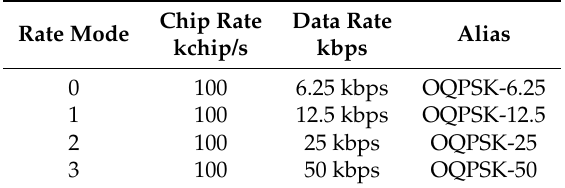
Table 3. Radio settings using O-QPSK modulation. The values of these parameters are defined in the standard [22]. The rate mode defines the resulting data rate. The radio signal is composed by chips; in the 868 MHz frequency band, the standard uses a fixed 100 kchip/s. The spreading mode defines the amount of chips needed to encode a bit of